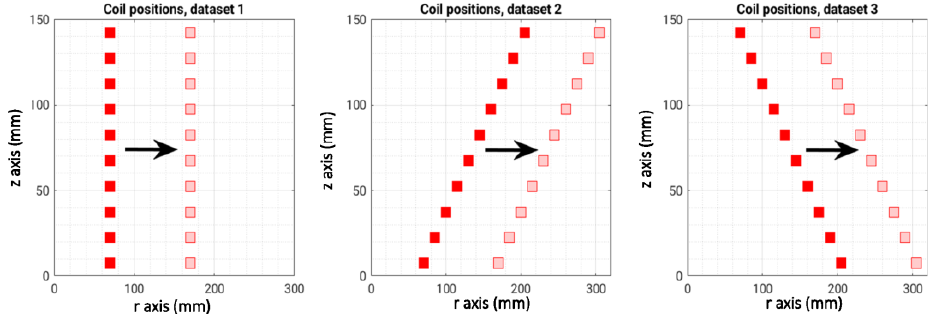
Figure 4. Coil positions in the three datasets.